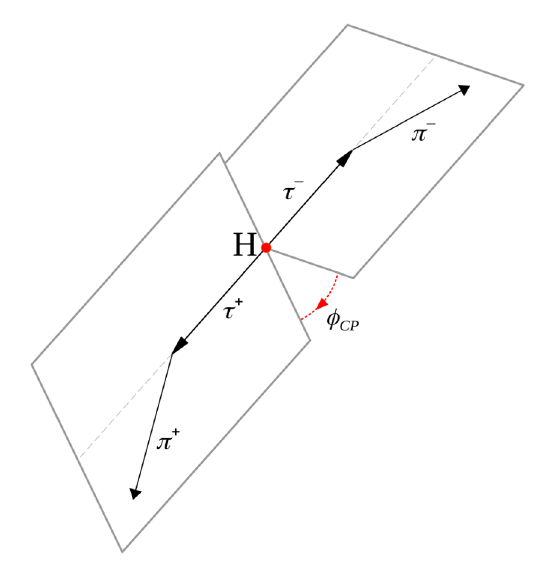
the angle between the decay planes. The illustration is in the H rest frame.